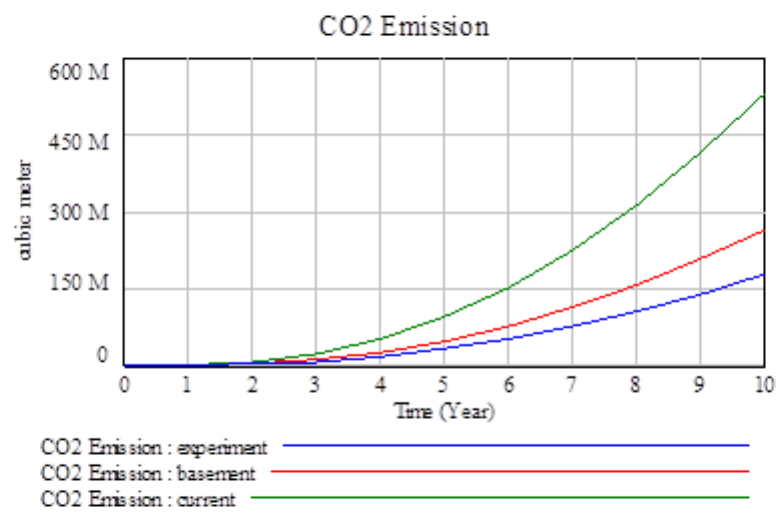
Figure 7. Experiment for CO 2 emission with changes of ASCAV